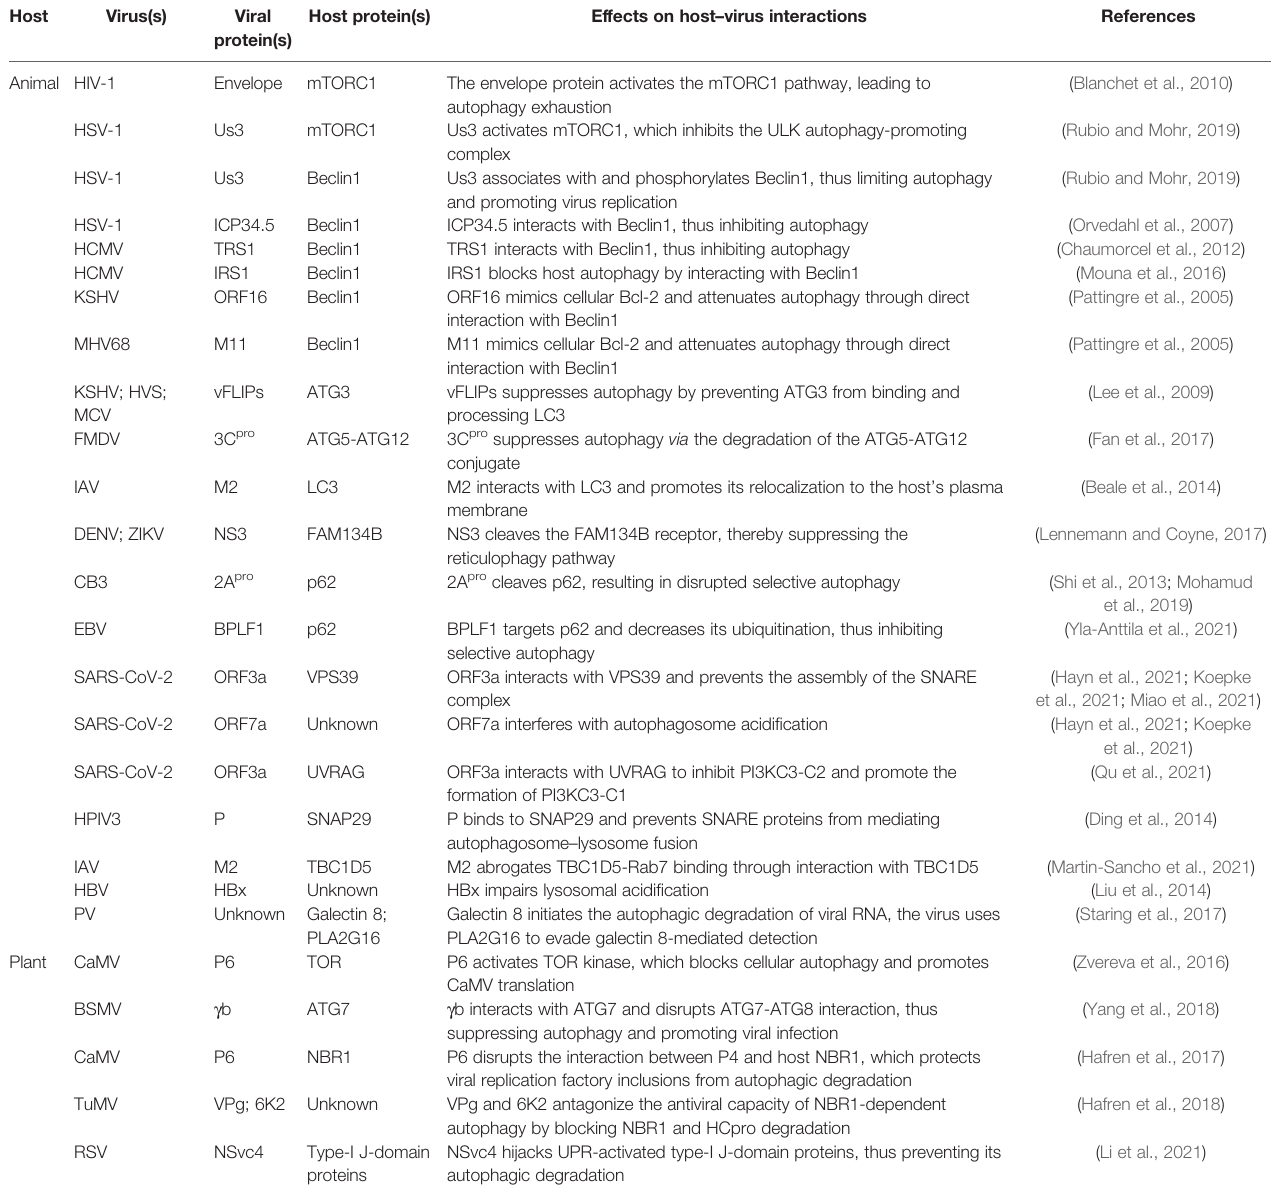
TABLE 2 | Autophagy is subverted by viruses. Virus(s) Viral Host protein(s)